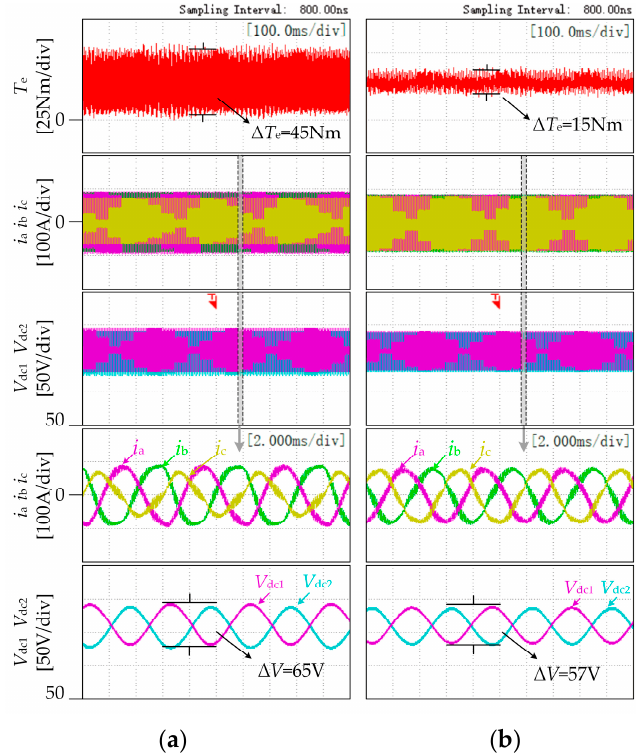
Figure 7. Experimental results at 2500 r/min and 30 Nm: ( a ) without capacitor voltage offset suppression; ( b ) proposed method.